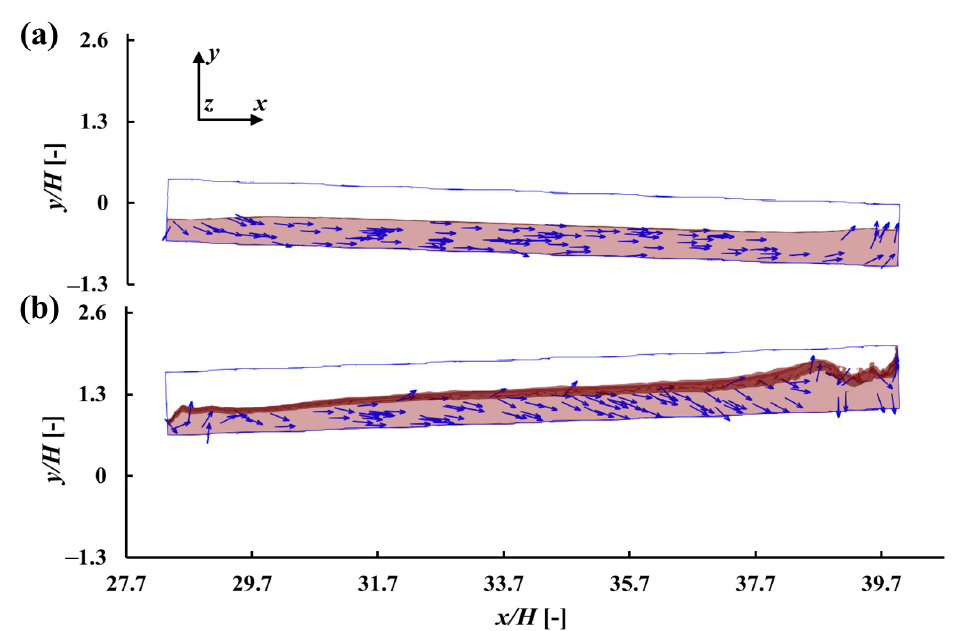
Figure 6. Snapshots for the sloshing tank with D i = 1.0 and N c = 1 at ( a ) t / T = 0.0 and ( b ) t / T = 0.5. Water phase is shown as transparent red with dark red representing the free surface. Blue arrows show the general direction of motion of the sloshing